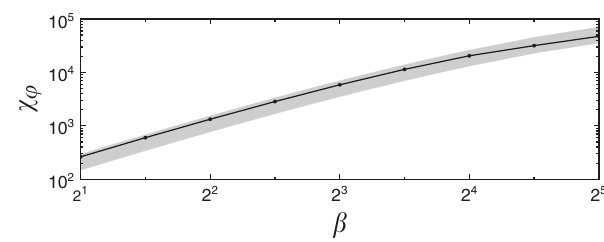
Fig. 4 Fidelity susceptibility for the thermal state. Exact fi delity susceptibility for a thermal many-body state (dots connected by the line) at the critical point in function of dimensionless inverse temperature β in the XX model (Eq. 26) with 64 spins. The shaded band shows the bounds (Eq. 25). As predicted in refs. 39,40 , the exact value tends to the upper/ lower bound for